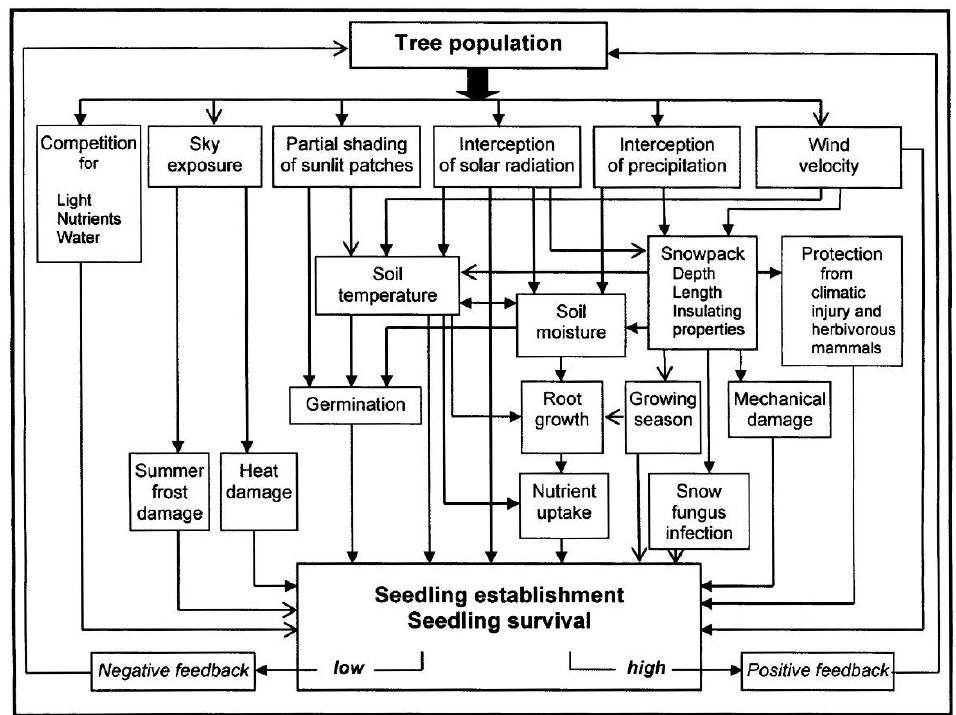
Figure 5. Feedbacks of increasing tree population on site conditions, seedling erstablishment, and survival (modified from [2]).